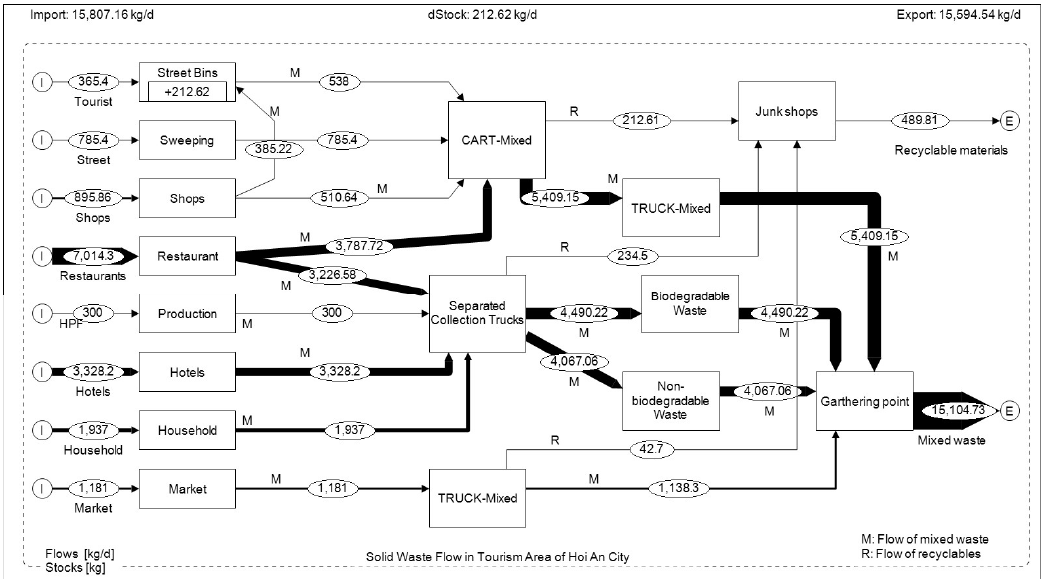
Fig. 2: The S0 (existing solid waste collection in TDoHAC) (Song Toan et al. , 2019)